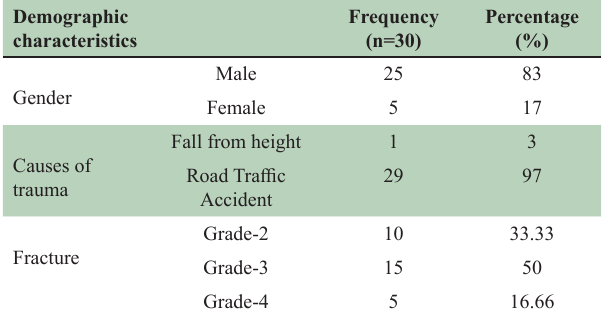
Table-II: Bony Union Different follow-up time